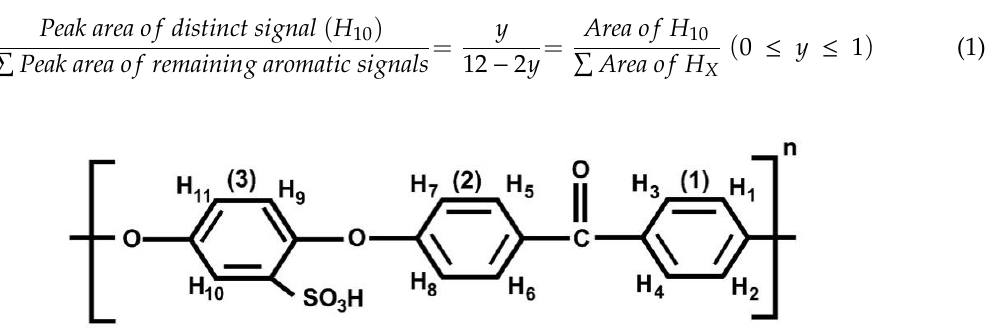
Figure 1. Nomenclature of aromatic protons of sulfonated poly ether ether ketone (SPEEK) .